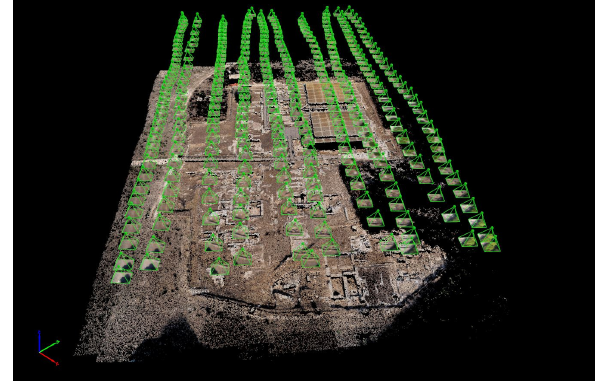
Figure 9. Camera position of the Insulae flight.